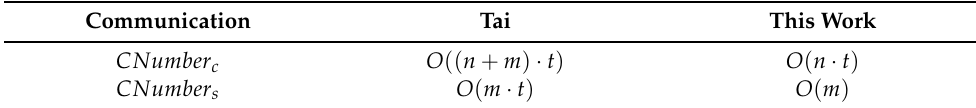
Table 1. Communication complexity at the side of the client and